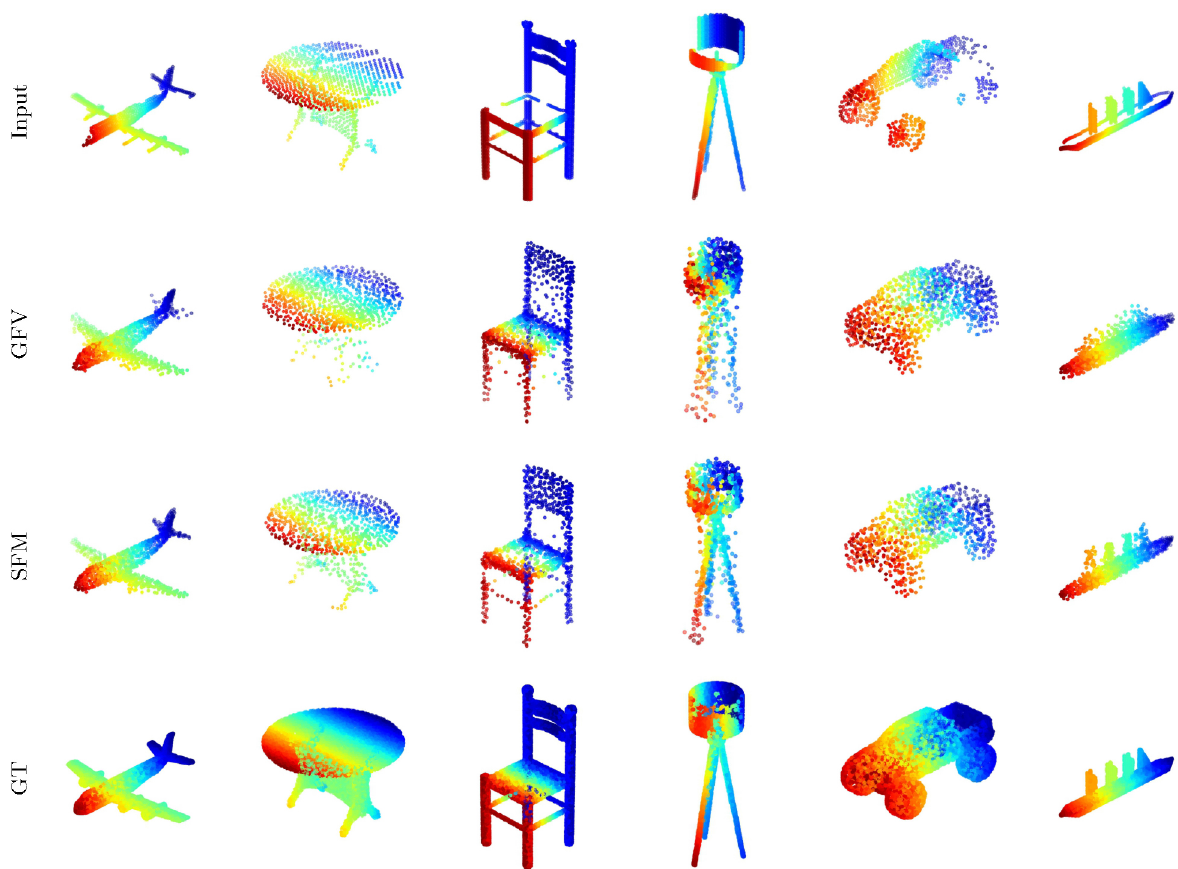
Fig. 9 Visual comparison of coarse point clouds generated by SFM and